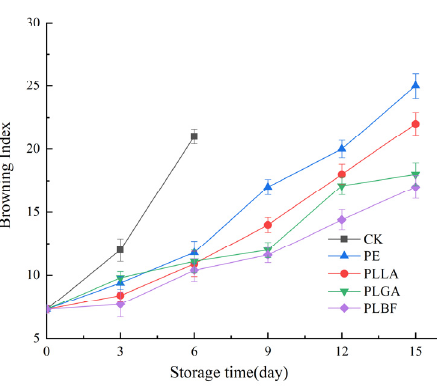
Figure 6. Changes of BI value of Agaricus bisporus in each packing group during storage.